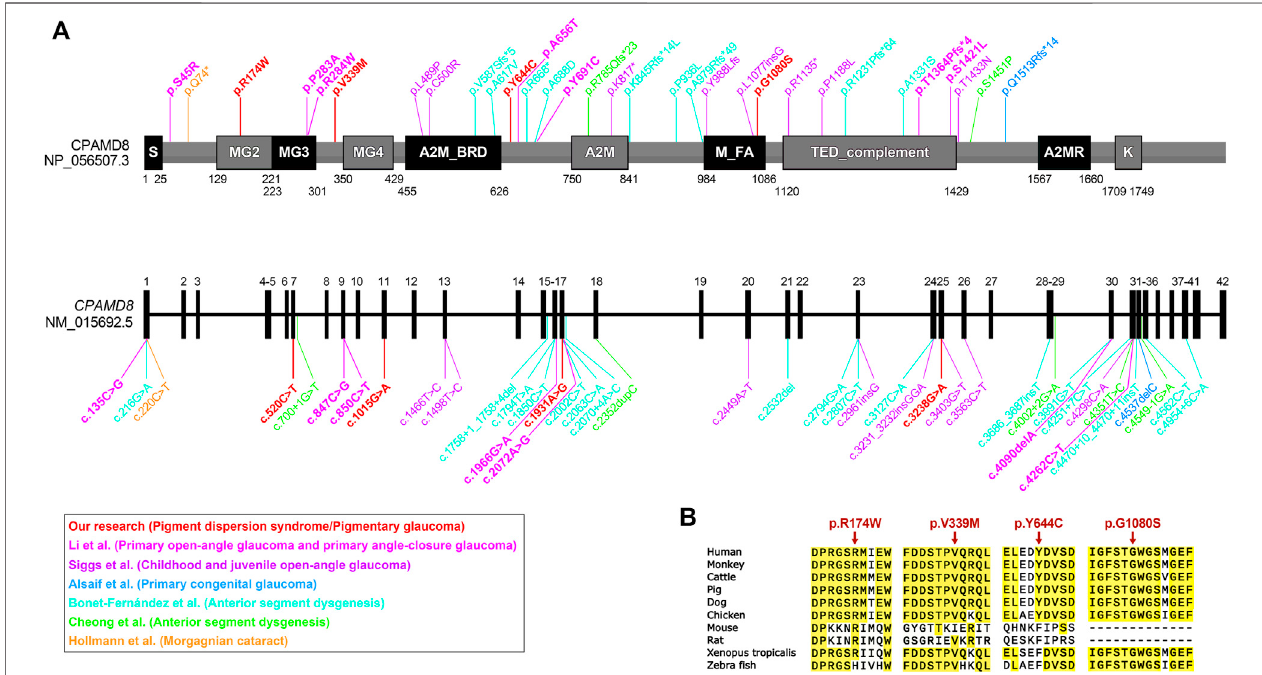
FIGURE 3 | Bioinformatics analyses of CPAMD8 variants in two PG pedigrees. (A) Schematic representations showing variant sites on the sequence of the CPAMD8 gene and CPAMD8 protein identi fi ed in our study and other studies of the association between CPAMD8 gene and inherited ocular disorders (Cheong et al., 2016; Hollmann et al., 2017; Alsaif et al., 2019; Bonet-Fernandez et al., 2020; Siggs et al., 2020; Li X. et al., 2021b). Each study was plotted in a distinct color. Domains were indicated according to the Pfam database (https://pfam.xfam.org/). Abbreviations: S, signal peptide; A2M, α -2-macroglobulin domain; A2M_BRD, α -2- macroglobulin bait region domain; A2MR, α -macroglobulin receptor binding domain; MG, macroglobulin domain of α -2-macroglobulin; M_FA, farnesoic acid O-methyl transferase domain; TED, α -macroglobulin thioester domain; K, kazal-2 serine protease inhibitor domain. (B) Sequence alignments of the CPAMD8 protein among different species. Four missense variants were highly conserved in various species. The positions of the variant amino acids are indicated by red arrows.